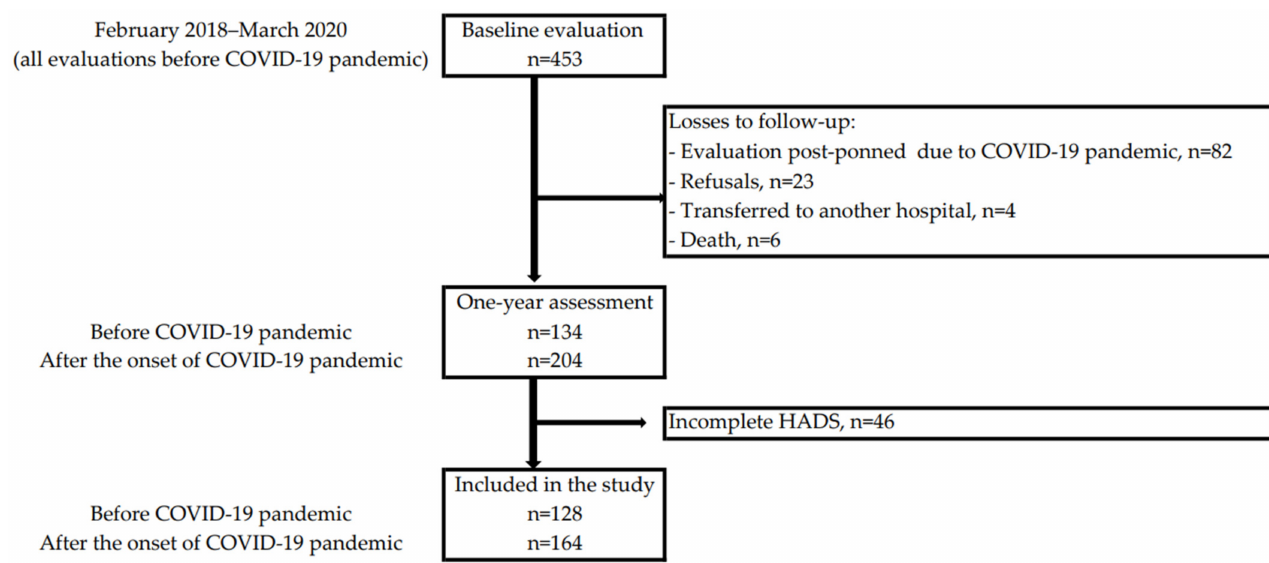
Figure 1. Flowchart describing the participation at each evaluation of the NEON-PC cohort and the participants included in the